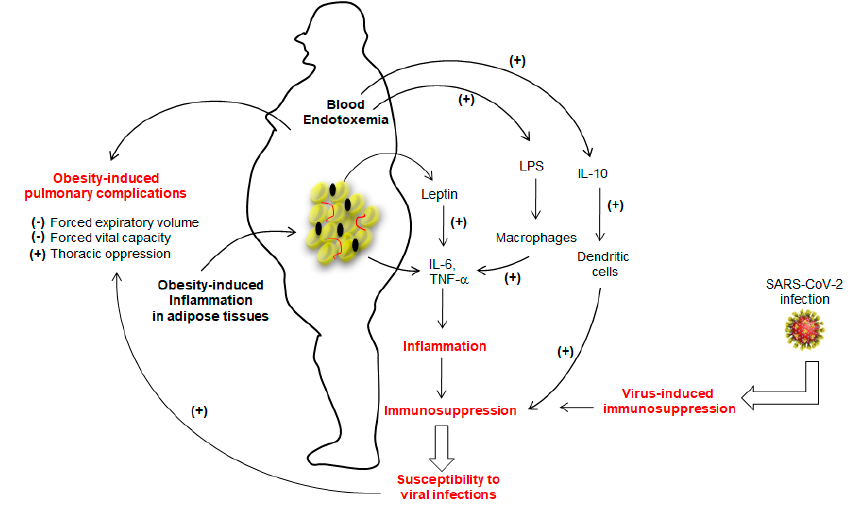
is highly inflamed and, consequently, releases a number of cytokines, particularly IL-6 and TNF- α. whose secretion is further potentiated by leptin. The lipopolysaccharide (LPS)-triggered endotoxemia further aggravates inflammatory condition by inducing the release of IL-6 and TNF- α from macrophages via TLR4 activation. Obesity is also marked with high production of IL-10, which decreases the function of dendritic cells. The prolonged inflammation will lead to immunosuppression that may favor the viral infection. Severe acute respiratory syndrome coronavirus-2 (SARS-CoV-2) has also been shown to induce immunosuppression. Once installed, SARS-CoV-2 will aggravate the obesity-induced lung dysfunctions. (+) and ( − ) show, respectively, stimulatory and inhibitory actions.